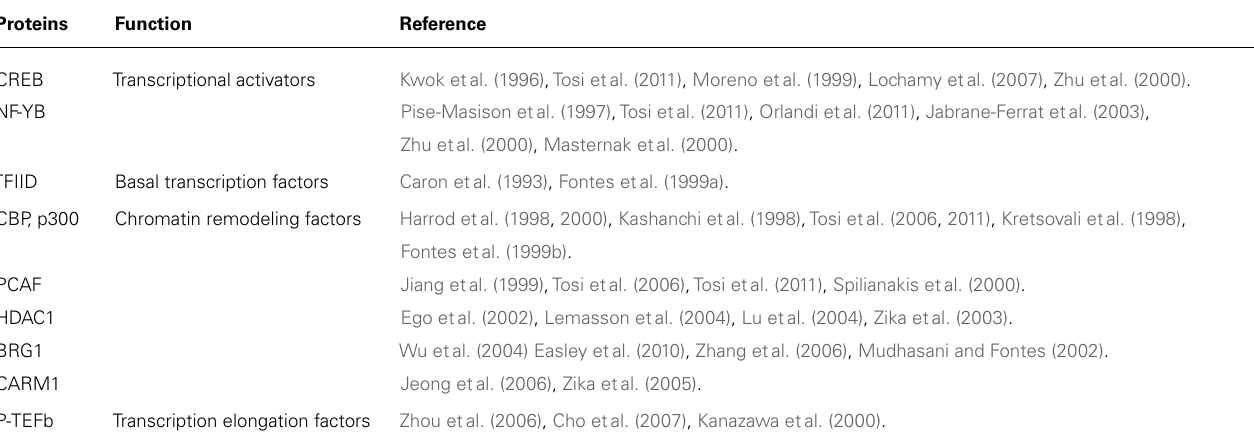
Table 1 | Physical and functional interaction shared byTax and